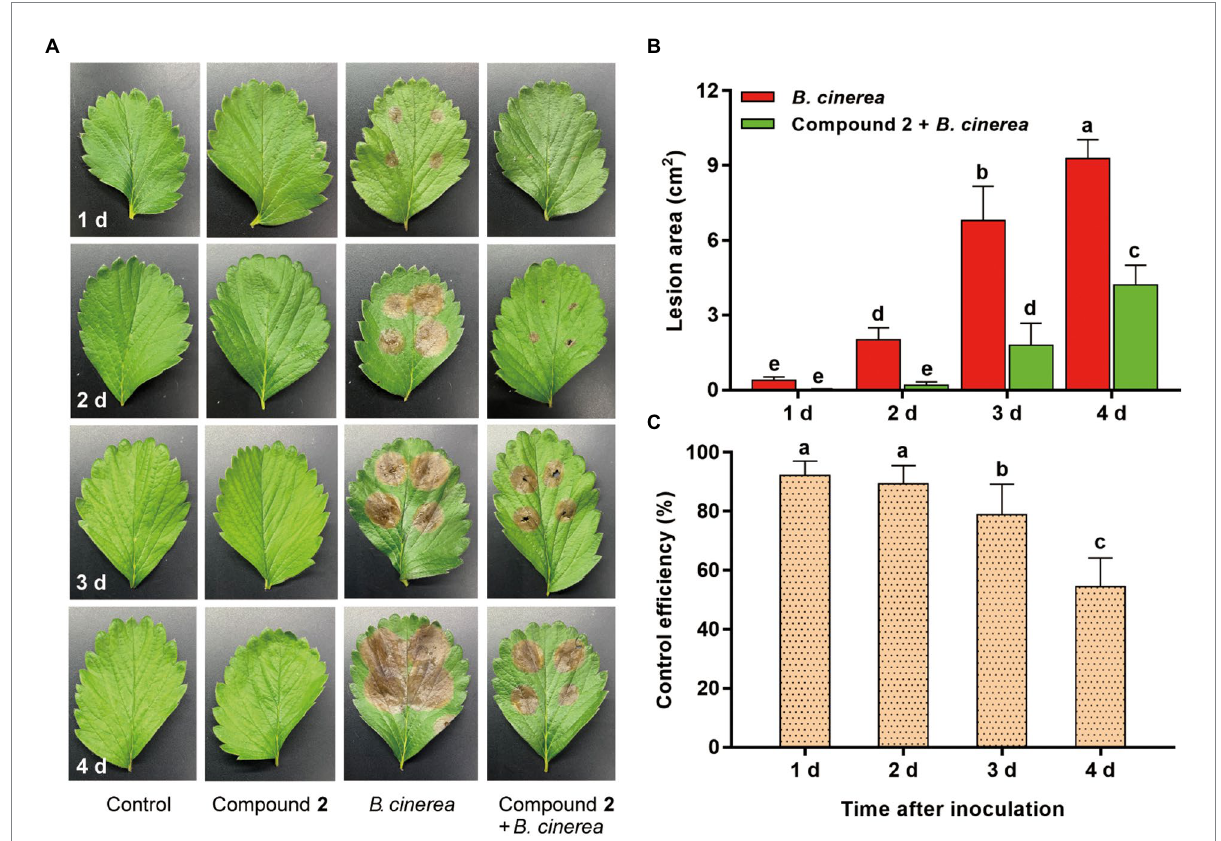
FIGURE 7 Bioassay of compound 2 against B. cinerea on detached strawberry leaves. (A) Symptoms on strawberry leaves in different treatments. (B) Lesion area on strawberry leaves in B. cinerea and compound 2 + B. cinerea treatment from 1 d to 4 d. (C) Control efficiency of compound 2 against B. cinerea ranging from 1 d to 4 d. Vertical bars represent the standard errors of the means. Different letters above the bars indicate statistically significant differences at p < 0.05.